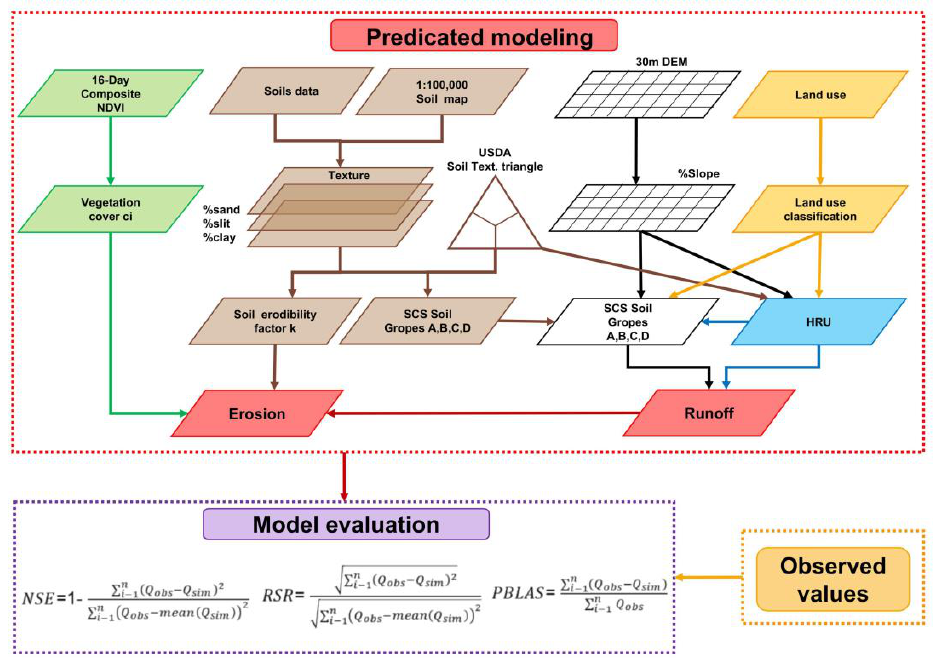
Figure 2. Schematic representation of data flow and processing.